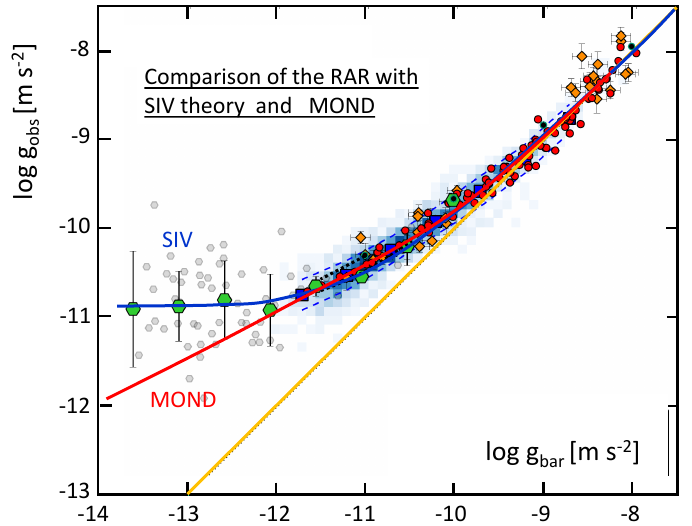
Figure 9. Observed values of g obs and g bar for the 240 galaxies studied by Lelli et al. [78], forming the radial acceleration relation (RAR). The big green hexagons represent the binned data of the dwarf spheroidal galaxies. The blue curve shows the relation predicted by (84) with a value of k 2 = 10 − 10.85 m s − 2 . The red curve gives the MOND relation [80] g = g N [ 1 − e − ( g N / a 0 ) a 0 = 1.20 · 10 − 10 m s − 2 , while the orange curve shows the